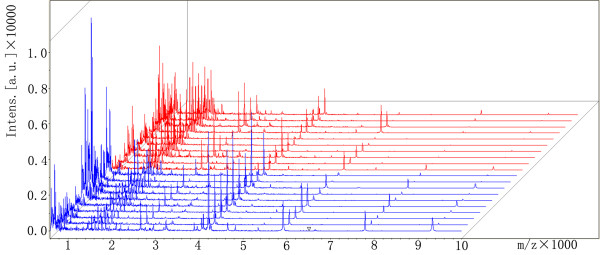
View of the aligned mass spectrum of the serum protein profile of model construction group obtained by MALDI-TOF after purification with WCX magnetic beads. Red represent 10 colorectal cancer patients, blue represent 10 healthy volunteers.